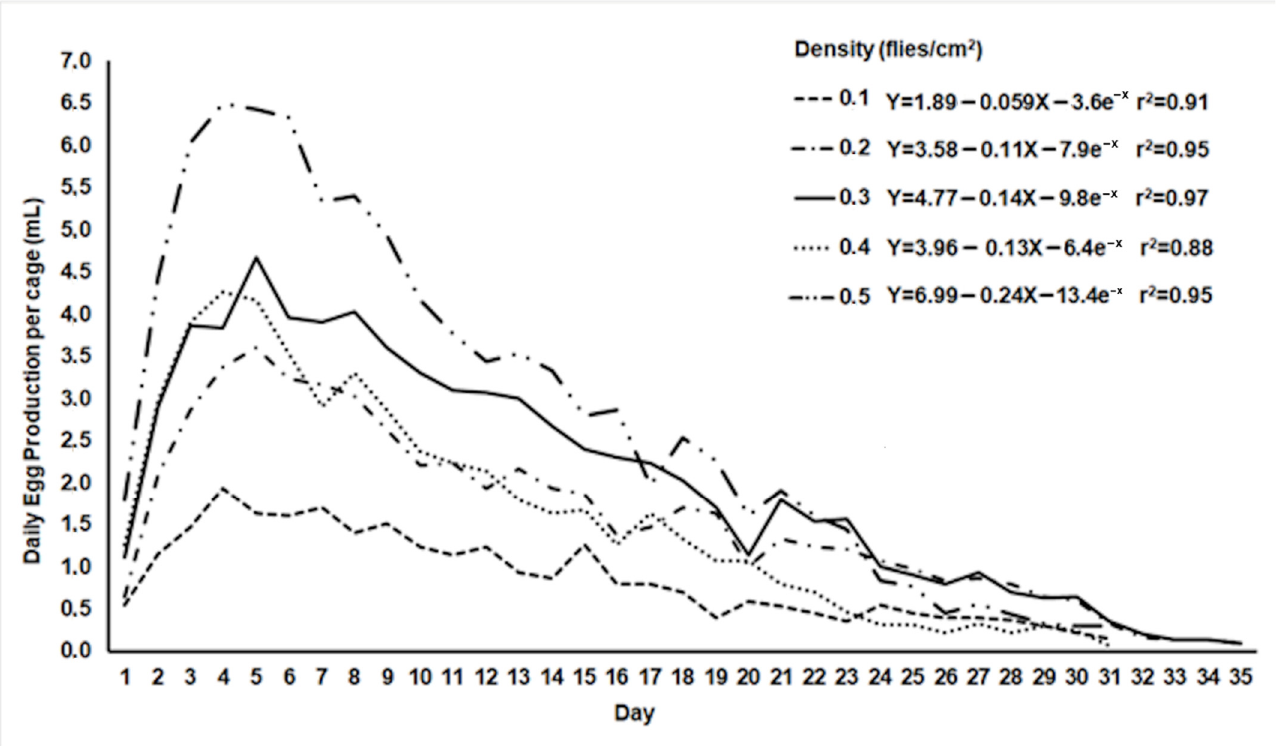
Figure 1. Observed mean volume of eggs collected daily from cages with Anastrepha fraterculus flies at five different adult densities.